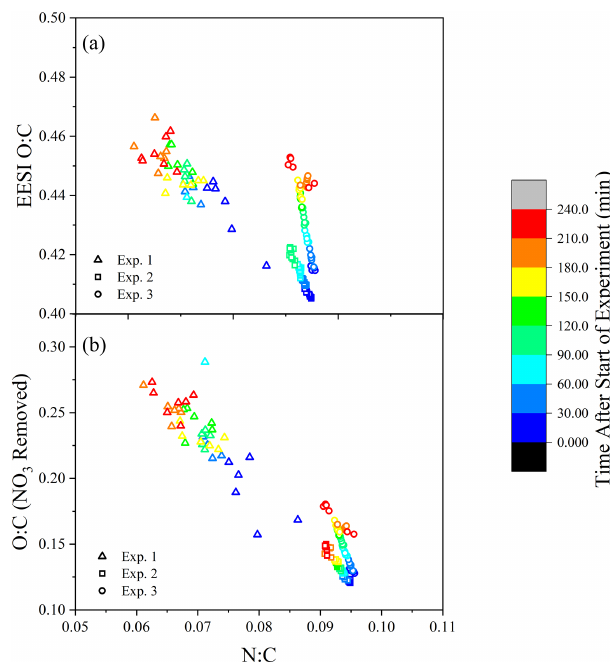
Figure 4. (a) The N : C and O : C ratios measured by the EESI-ToF over the course of the experiment (color scale). (b) The O : C ratio is altered by the removal of –ONO 2 groups where #O non − NO #O total – 3 ·